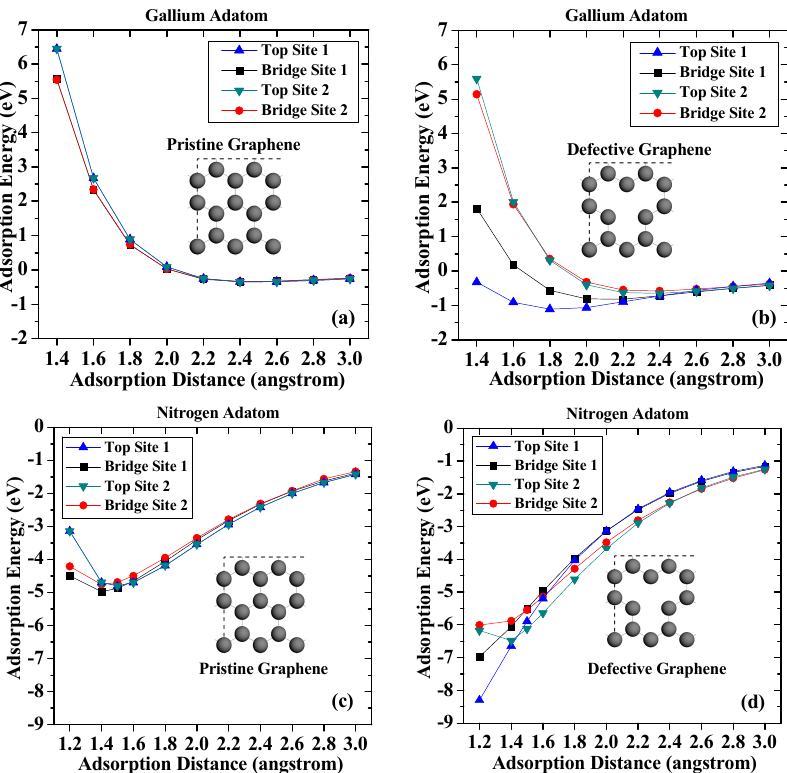
Figure 2. Adsorption energy curves of ( a ) the gallium adatom on pristine graphene; ( b ) the gallium atom on vacancy-defected graphene; ( c ) the nitrogen atom on pristine graphene; and ( d ) the nitrogen atom on vacancy-defected graphene.